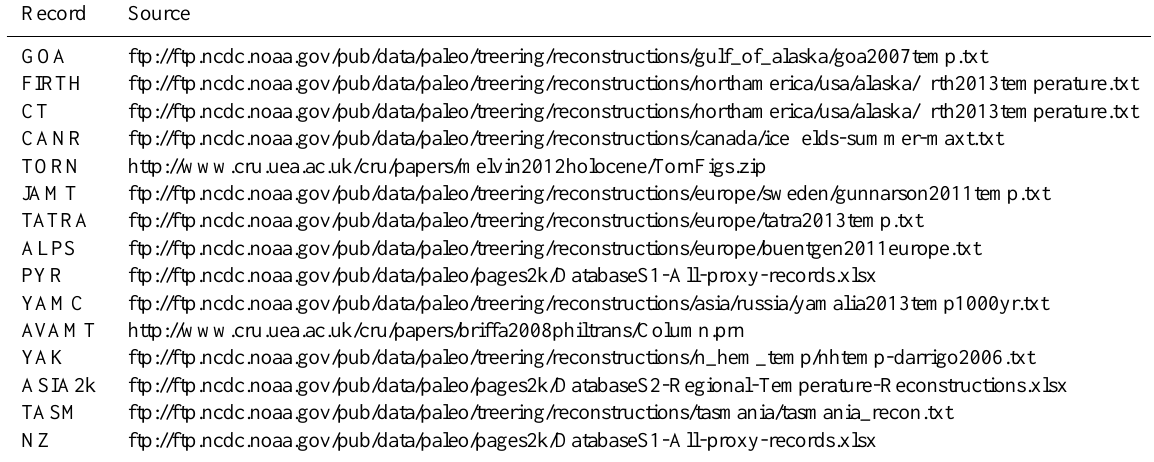
Table 2. Data sources for the tree-ring